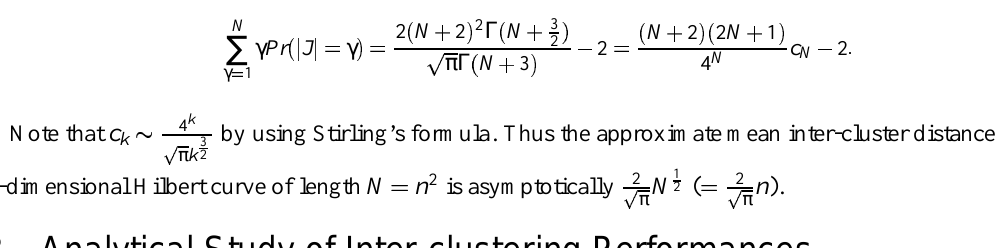
in (a) from a H 2 k